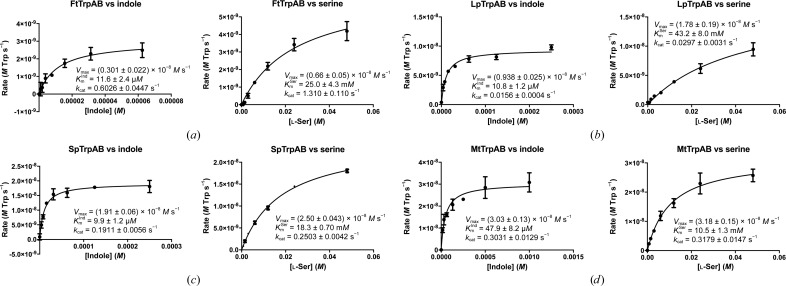
Kinetics of TrpAB orthologs. (a) FtTrpAB at 5 nM, (b) LpPhTrpAB at 600 nM, (c) SpTrpAB at 100 nM, (d) MtTrpAB at 100 nM. The left panels show reaction rates versus indole concentration in the presence of 48 mM
l-Ser; the right panels show reaction rates versus l-Ser concentration in the presence of 0.5 mM indole.